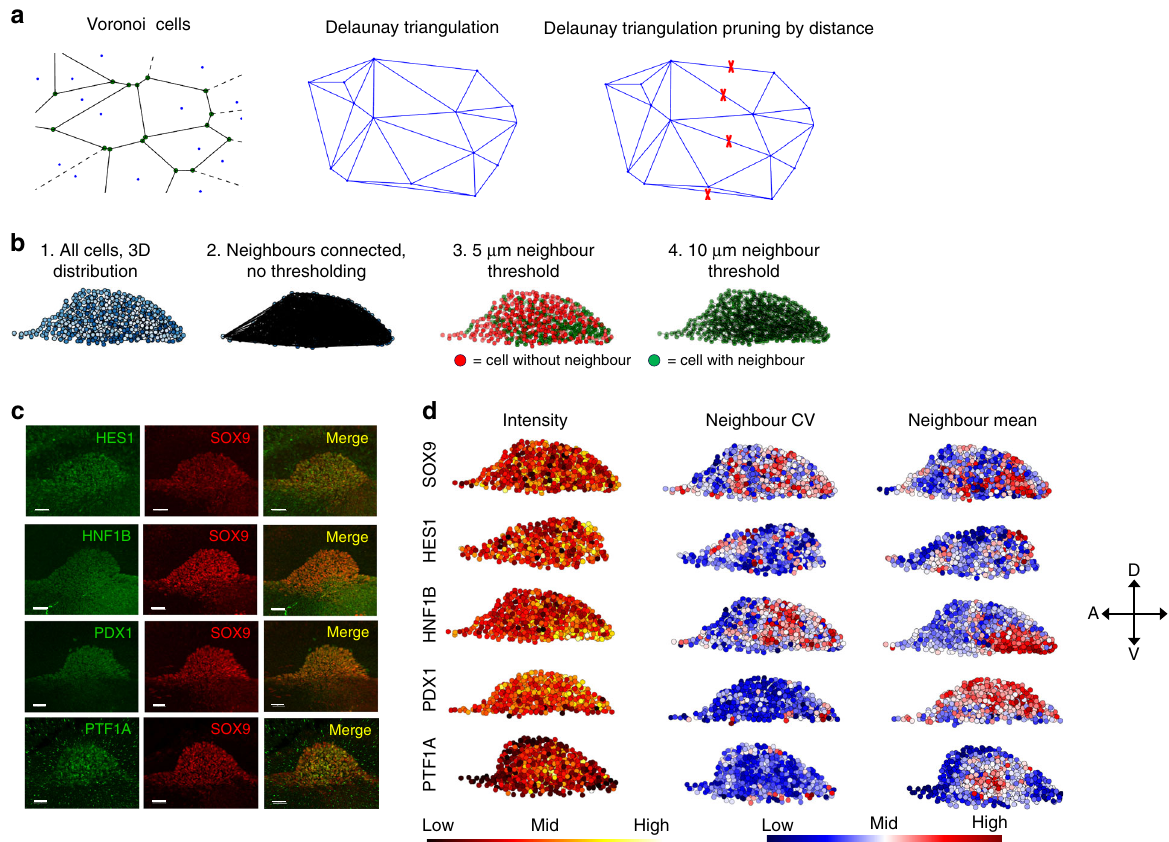
Fig. 3 E9.5 pancreatic progenitors display heterogeneous expression of pancreas-associated transcription factors and distinct patterns of neighbour cell expression correlation. a Schematic of Voronoi-Delaunay triangulation implemented to identify neighbour cells in 3D. Distance-based pruning was implemented in order to identify biologically meaningful neighbours in 3D space. b Example of Voronoi-Delaunay triangulation-mediated neighbour identi fi cation in E9.5 pancreatic bud. Cells colour-coded according to z-position (1) are subjected to Voronoi-Delaunay triangulation, identifying all neighbour relations in 3D (2). Implementation of a distance threshold of 5 μ m (3) or 10 μ m (4) generates different number of cells with and without 3D neighbours ( green and red cells, respectively). For all downstream analyses, 10 μ m was chosen as neighbour distance threshold. c Example of transcription factor expression pattern in E9.5 pancreatic buds following whole-mount staining. 3D MIP is displayed. Scale bars, 30 µ m. d 3D plots of staining intensity, neighbour coef fi cient of variation and neighbour mean intensities from immunostaining against the indicated transcription factors. Note the heterogeneous expression patterns of HES1, SOX9 and PTF1A and the regionalised expression of HNF1B (posterior) and PTF1A (lateral) ( n = 2 for all, except n = 8 for SOX9. The images displayed show representative data from index: 35 clones in 120 pancreata, 29%; probability of double labelling, 8%) resulted in a similar pattern of clones as observed with Rosa26 CreER , that is unipotent endocrine, bipotent ducto- endocrine as well as multipotent clones (Fig. 4b, c and f).